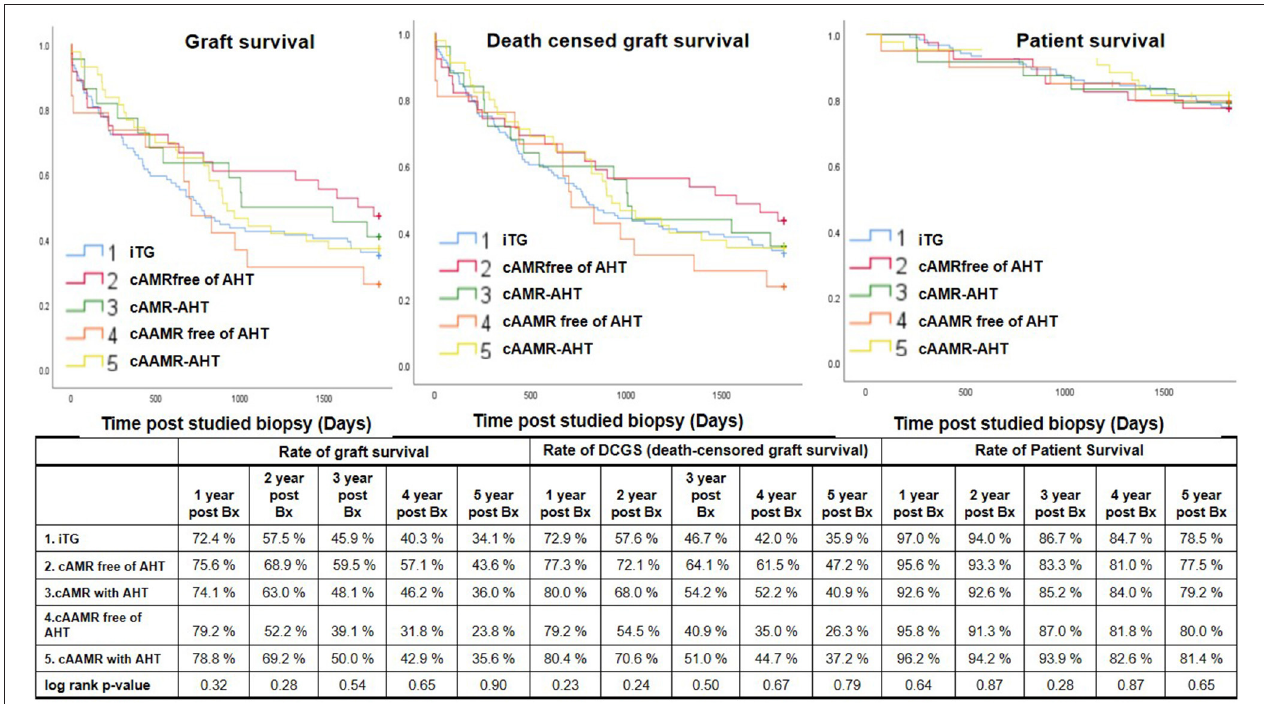
FIGURE 4 | The effect of AHT on the 5-year post Bx graft survival rates (left) , DCGS rates (middle) and patient survival rates (right) . AHT, antihumoral therapy; Bx, the studied